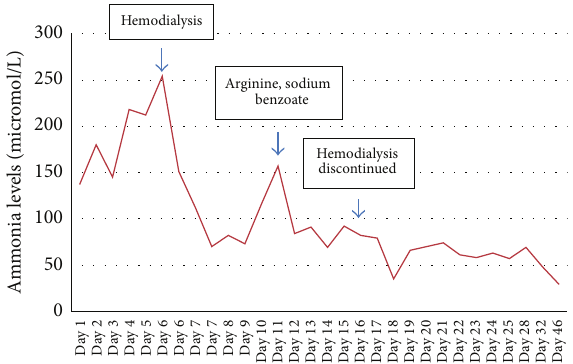
Figure 1: Effect of hemodialysis, arginine, and sodium benzoate on ammonia levels in late-onset OTC